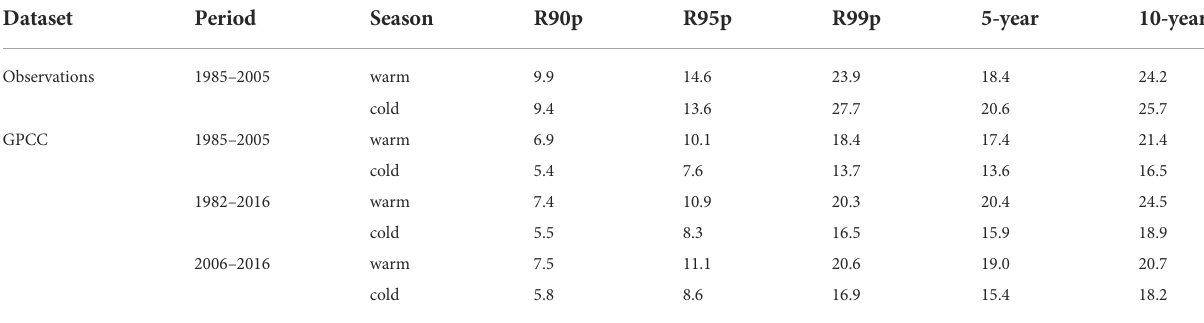
TABLE 4 Threshold in different period by GPCC dataset and